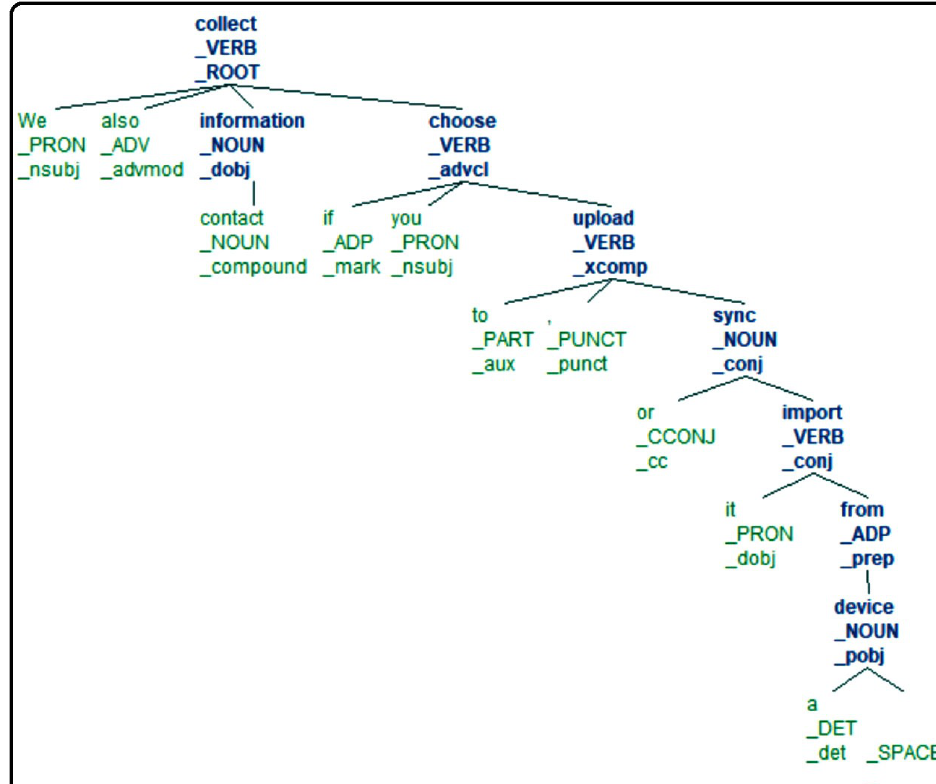
Figure 5. Policy (M1) upon dependency parser processing.